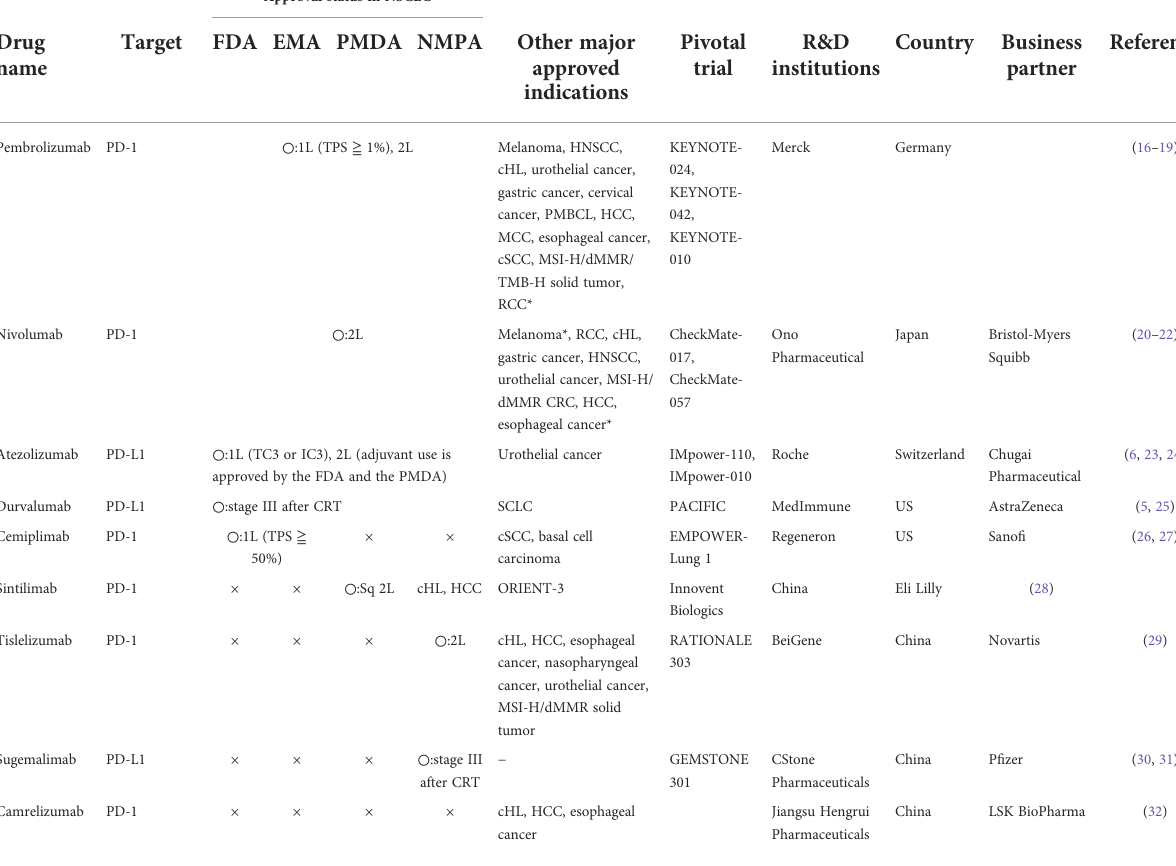
TABLE 1 Anti-PD-1/PD-L1 antibody monotherapy currently approved and under development (data on March 31, 2022). Approval status in